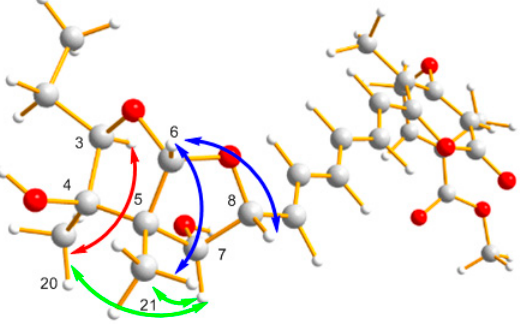
Figure 3. Key NOESY correlations of 1 .